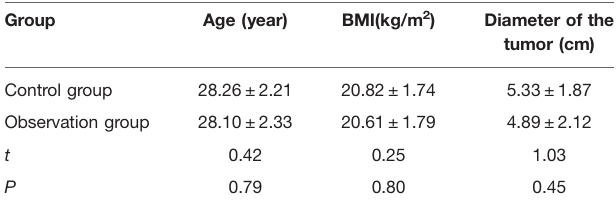
TABLE 1 | Comparison of the baseline characteristics between the two groups of